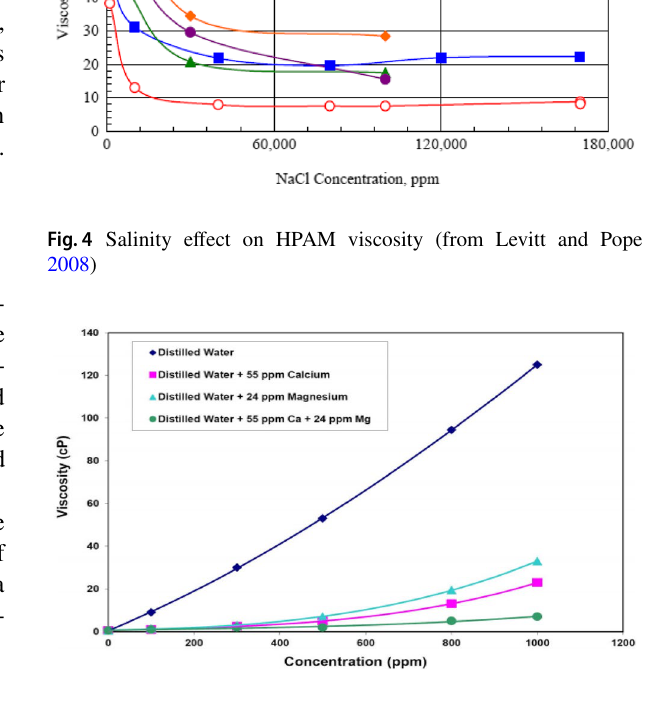
Fig. 5 Divalent effect on HPAM viscosity (from Melo et al.